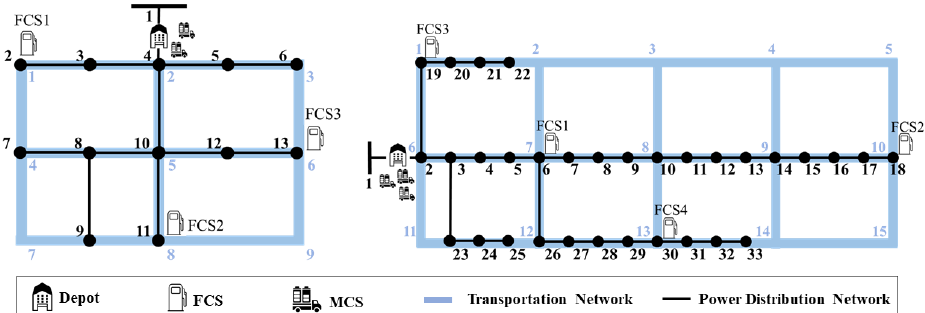
Figure 4. IEEE 13-bus power distribution system with 9-node transportation system and IEEE 33-bus power distribution system with 15-node transportation system.